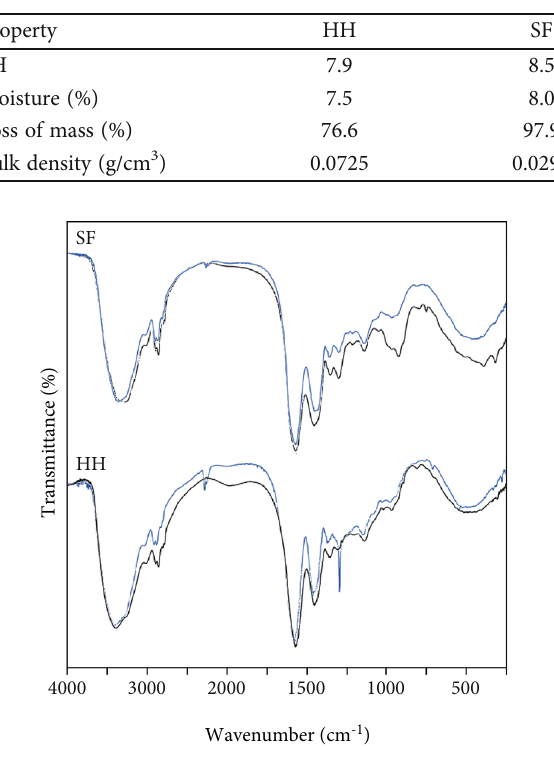
Figure 1: FTIR spectra of keratinous biomaterials applied to remove heavy metals from aqueous solutions. Black line: virgin adsorbent; blue line: metal-loaded